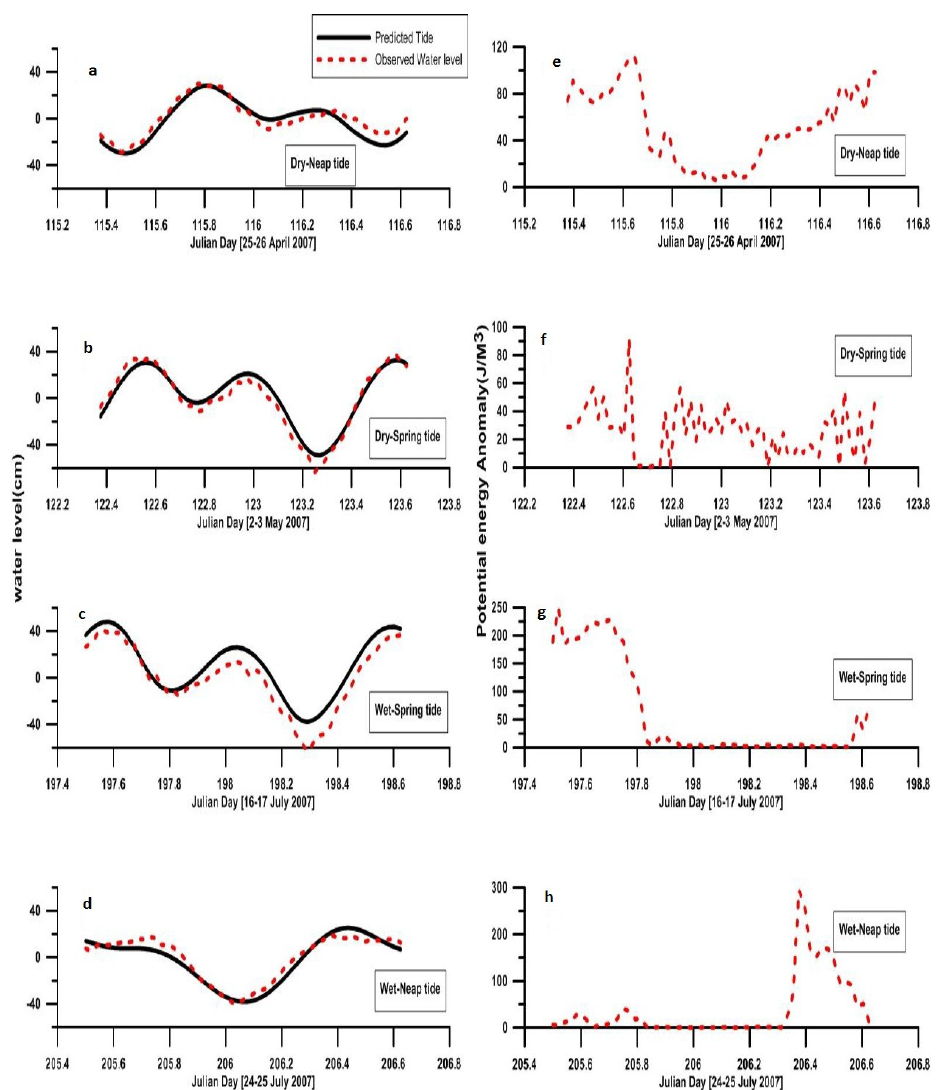
Fig. 3. (a–d) Semidiurnal variations of observed water level and predicted tide at the location; (e–f) Time series of potential energy anomaly ( ϕ ) (Jm − 3 ) computed from the 30min density profiles (a, e) 25 April 09:00LT to 26 April 15:00LT (neap-dry); (b, f) 2 May 09:00LT to 3 May 15:00LT (spring-dry); (c, g) 16 July 12:00LT to 17 July 15:00LT (spring-wet); (d, h) 24 July 12:00LT to 25 July 15:00LT